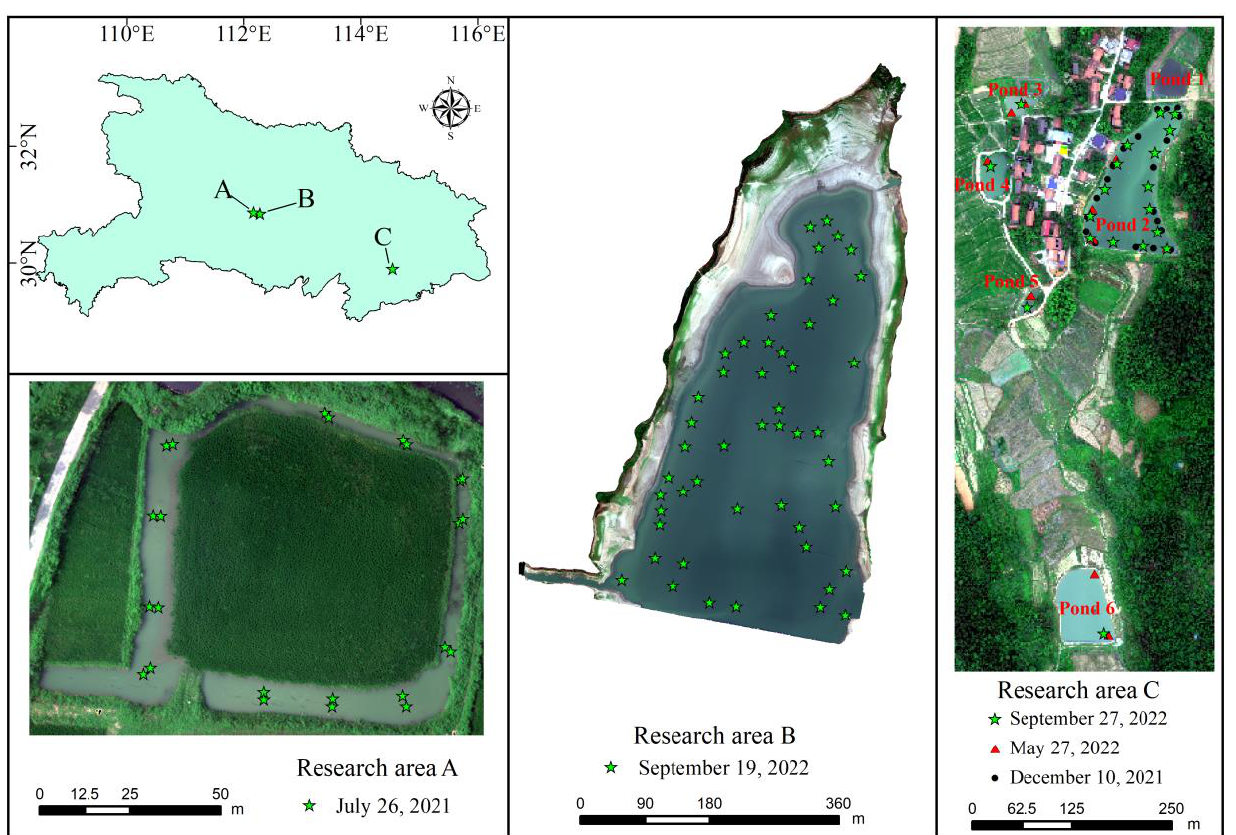
Figure 1. Locations and true color images from UAV multispectral images of the three research areas and geographical distribution of the sampling sites and times .